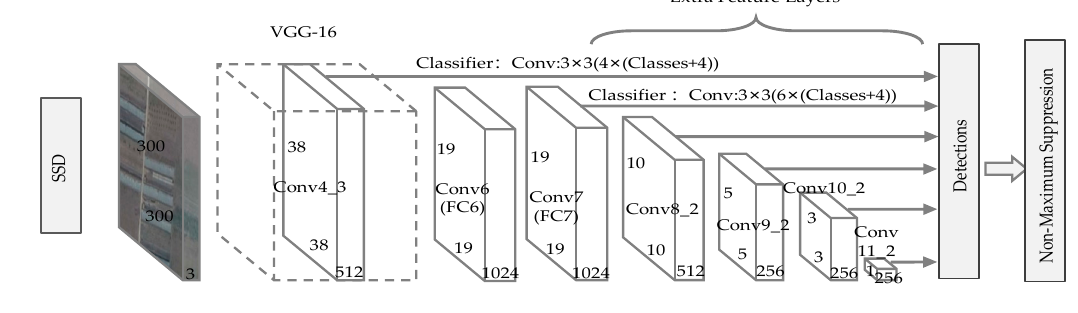
Figure 4. Overall architecture of SSD.